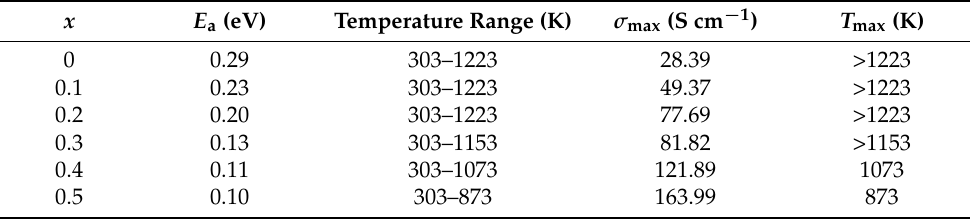
Table 1. Activation energies E a of Pr 1– x Sr x (Cr,Mn,Fe,Co,Ni)O 3– δ ( x = 0–0.5) membranes determined from the linear range of the Arrhenius plots shown in Figure 6b. σ max and T max are the maximum values of electrical conductivity and corresponding temperature among the measured data